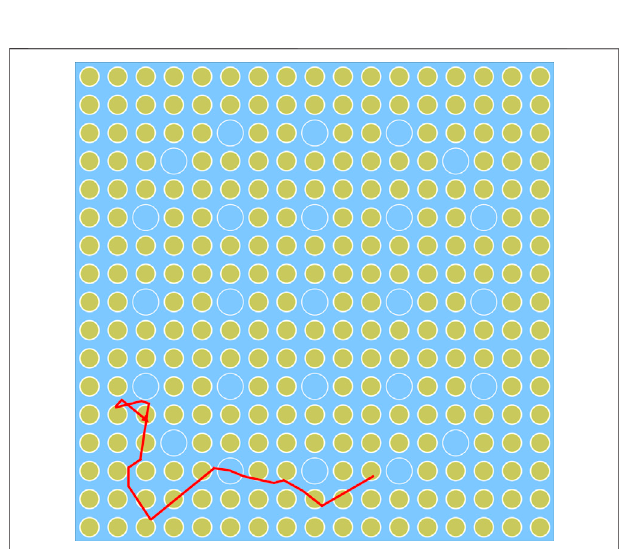
FIGURE 1 | A diagram of the combined fi ssion matrix theory in a two-assembly model.